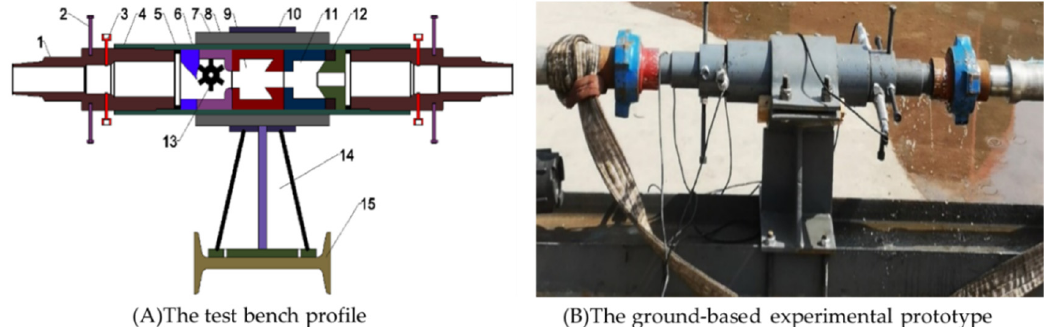
Figure 7. The test bench of multi − source pulse jet generator. 1—pipeline joint; 2—bolt; 3—base of pressure testing apparatus; 4—sleeve sub; 5—lock washer; 6—runner base; 7—pads; 8—impeller